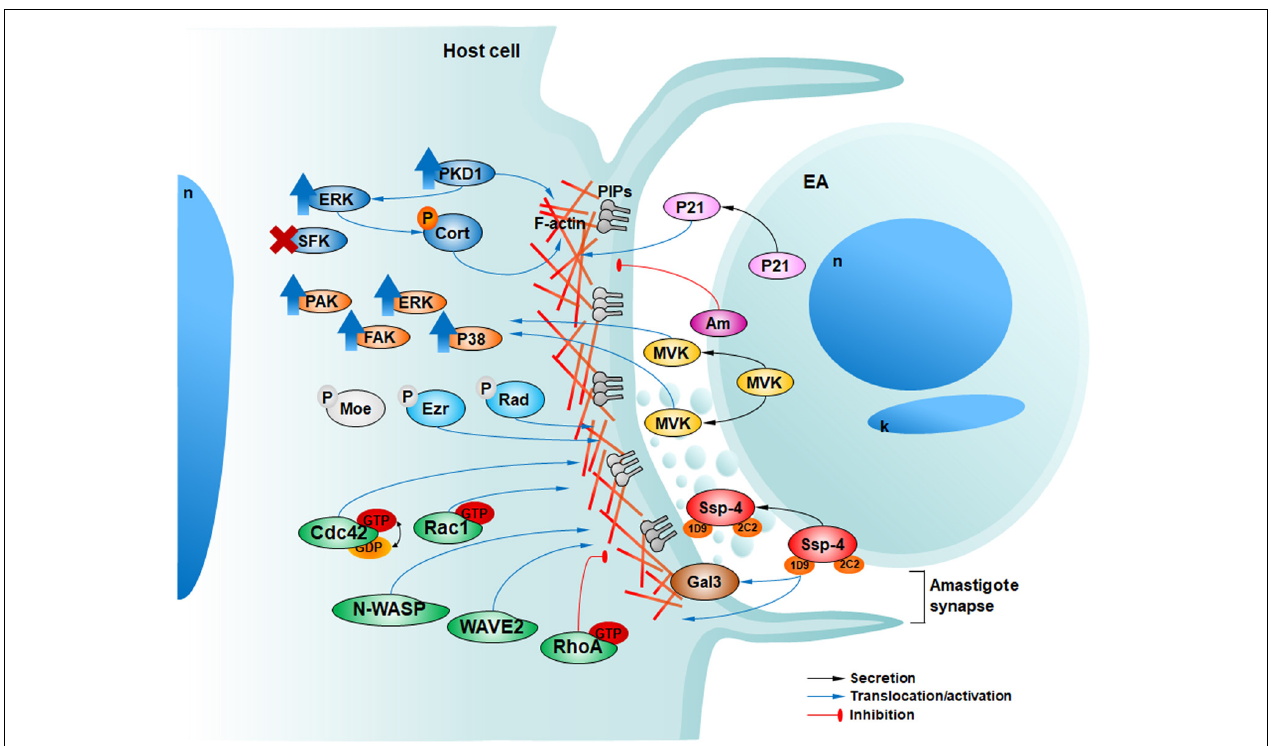
FIGURE 2 | Host and parasite factors recently described by our group involved in HeLa cell invasion by EAs. In 2009, we described the secretion of P21 (pink) and its positive modulation of EA internalization (da Silva et al., 2009). In 2012, we showed that EAs can also engage negative modulators of invasion such as the surface protein amastin (purple, Am) (Cruz et al., 2012). In 2013, we showed that EAs mobilize host phosphoinosites (light and dark gray) along with actin in a phagocytosis-like mechanism (Fernandes et al., 2013). In 2015 Bonfim-Melo et al. (2018) described the activation (upward blue arrows) of PKD1 and ERK but not SFKs upon EA-HeLa interaction with cortactin and PKD1 phosphorylation (orange P) and participation in EA invasion. In 2016 Ferreira et al. (2016) described that TcMVK (yellow) is secreted by EAs promoting their invasion and the activation of diverse actin related host proteins (orange). Additionally, in 2017, we described that ezrin and radixin (cyan), but not moesin (light gray) are involved in actin regulation and EA invasion independent of their phosphorylation (light gray P) activation mechanism (Ferreira et al., 2017). Recently, we observed the participation of Rho GTPases (Rac1 and Cdc42) and their effector proteins regulating actin polymerization signaling and promoting EA invasion, although RhoA inhibited these events (green) (Bonfim-Melo et al., 2018). The surface protein Ssp-4 is differentially expressed among T. cruzi strains and can modulate EA invasion through its 1D9 carbohydrate epitope, ligand of host galectin-3 (brown)